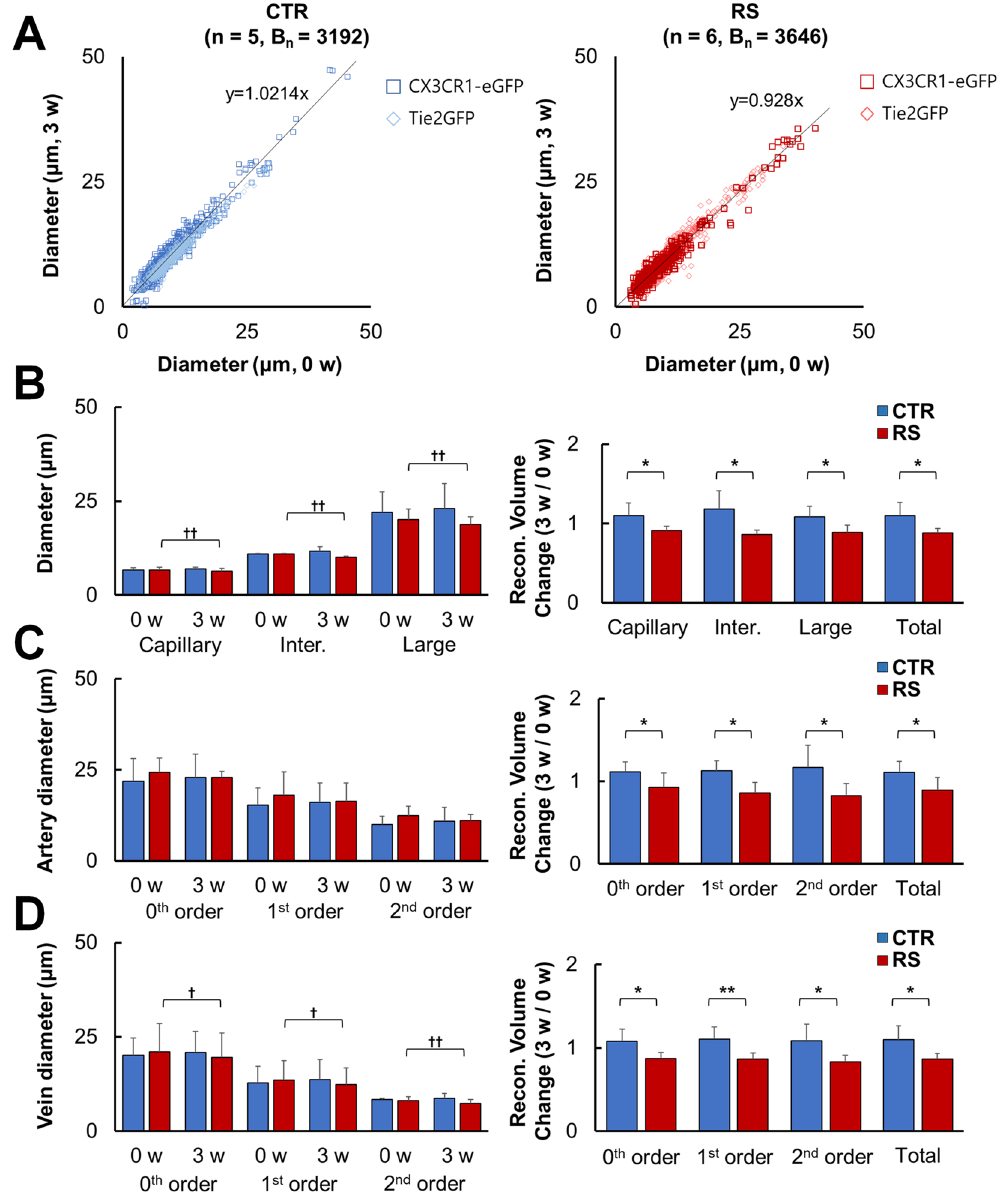
Figure 3. Volume and diameter of classified vessels based on size, type, and branching order. ( A ) The correlation of vessel diameter between 0 w and 3 w of the CTR (left) and RS (right). ( B ) The diameter of vessel at 0 w and 3 w in all sizes of vessels (left), and the reconstructed volume change shown as the ratio to 0 w (right). ( C ) Artery diameter (left) and reconstructed volume change (right) in the CTR and RS based on branching order. ( D ) Vein diameter (left) and reconstructed volume change (right) in the CTR and RS based on branching order. CTR, control group; RS, restraint stress group; B n , number of branches; * p < 0.05; ** p < 0.01; † p < 0.05; †† p <